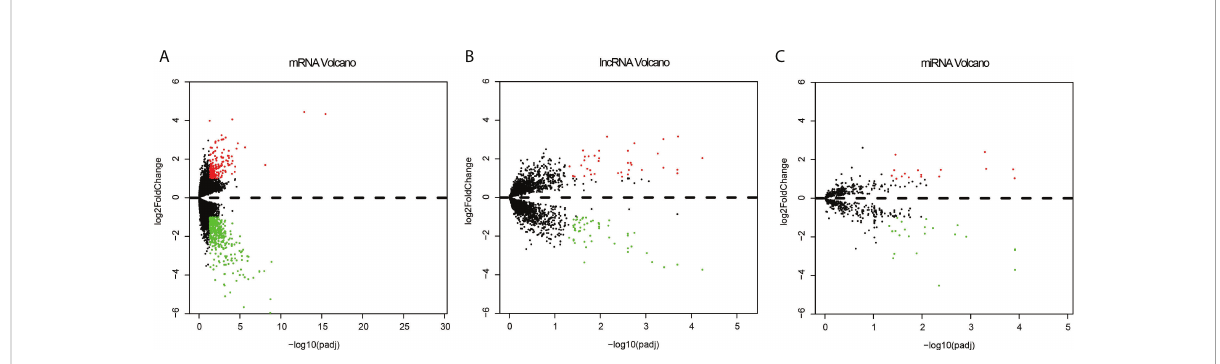
FIGURE 2 Volcano plots of the differentially expressed mRNAs (A) , lncRNAs (B) and miRNA (C) between the recurrent or metastatic group and non- recurrent or metastatic group. Red represents up expression and green represents down expression. Black indicates the expression with both the absolute log2FC > 1 and Padj < 0.05. The X axis shows an adjusted P value and the Y axis shows a